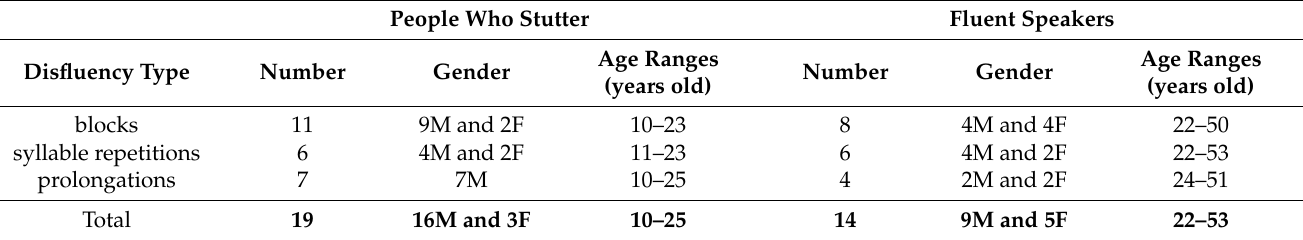
Table 1. Characteristics of stutterers and fluent speakers regarding realised disfluency, age and gender. People Who